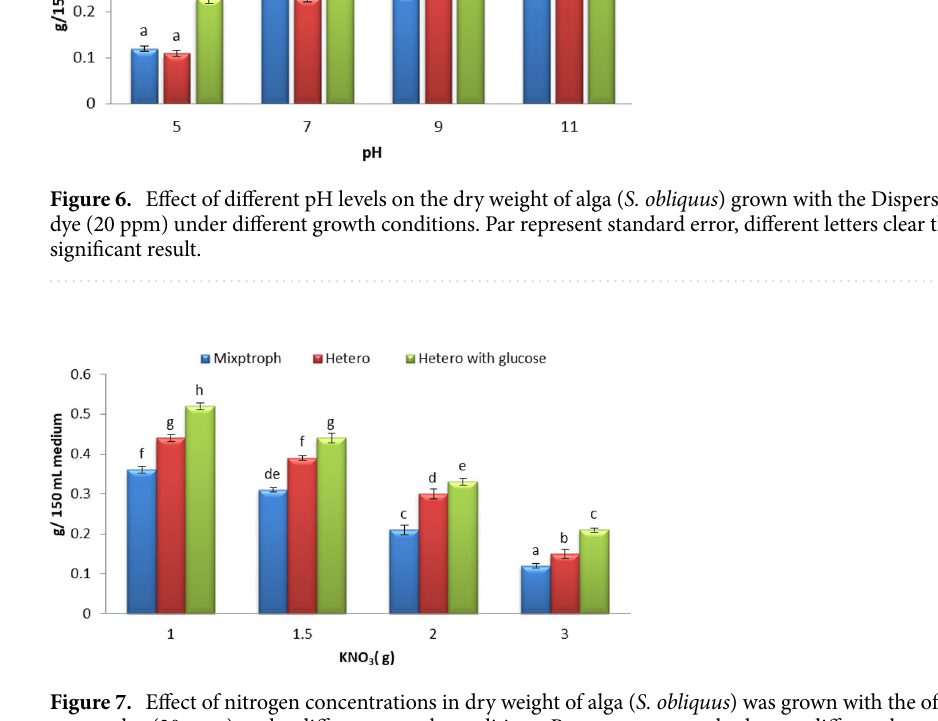
KNO 3 . The results in Fig. 7 represent the maximum S. obliquus dry weight (0.52 g) obtained with 1 g KNO 3 / liter of the medium, when was grown in heterotrophic conditions and medium supplemented with glucose,